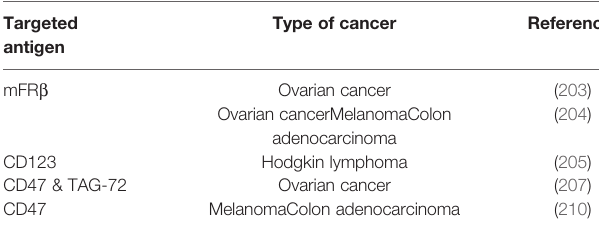
TABLE 5 | Summary of preclinical studies on CAR-T cells engineered to overcome the immunosuppressive effect of TAMs. Targeted Type of cancer antigen